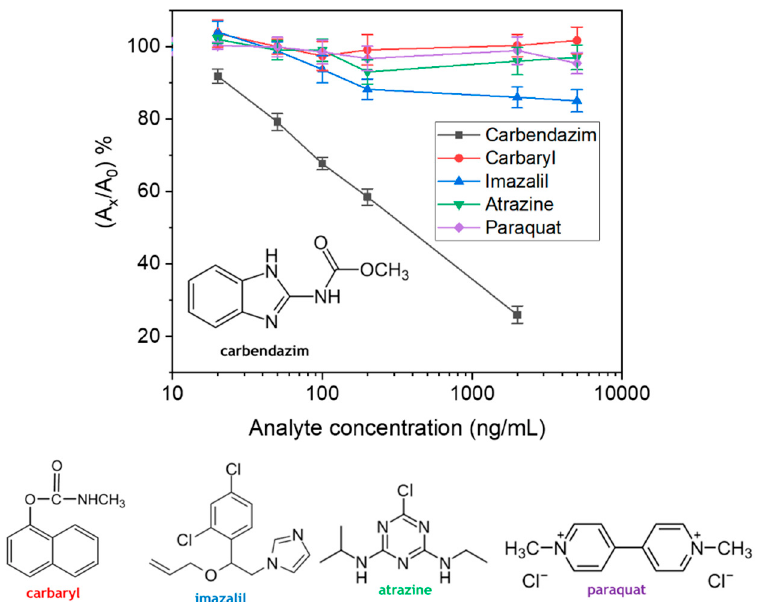
Figure 2. Calibration plots obtained with carbendazim (black squares), carbaryl (red circles), imazalil (blue up triangle), atrazine (green down triangle), and paraquat (purple rhombus) standards with concentrations ranging from 0 to 5000 ng/mL. All standards were preincubated for 60 min with the anti-carbendazim antibody prior to addition in the microwells. Each point is the mean value of 3 replicates ± SD.